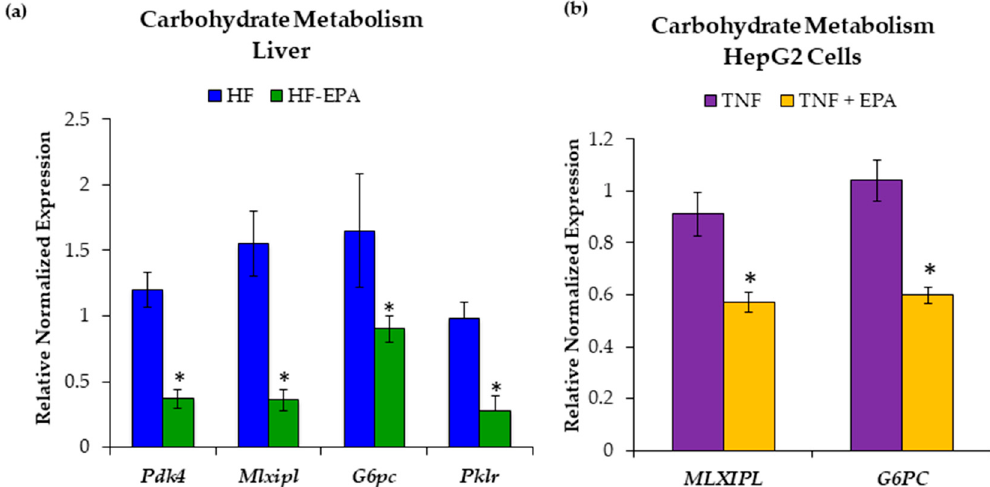
Figure 5. Eicosapentaenoic acid (EPA) supplementation alters carbohydrate metabolism. ( a ) Gene